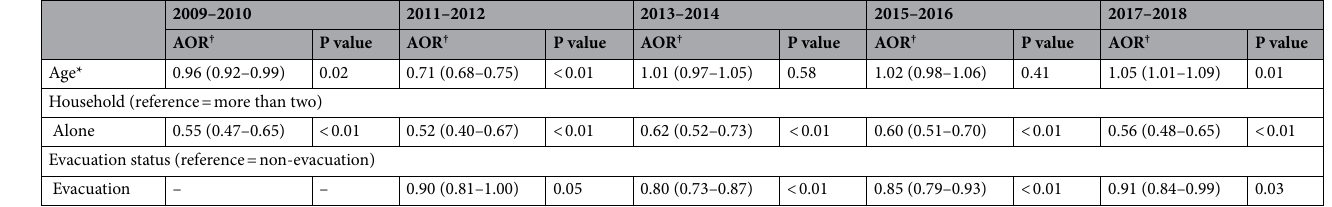
Table 3. Cross-sectional logistic regression models for breast cancer screening uptake in every two-year period from 2009 to 2018. *Odds ratios were calculated based on 10 years interval. † AOR = Adjusted odds ratio; multivariable logistic regression models were developed to assess the probability of participation in the screening program for every two-year period ranging from 2009 to 2018.